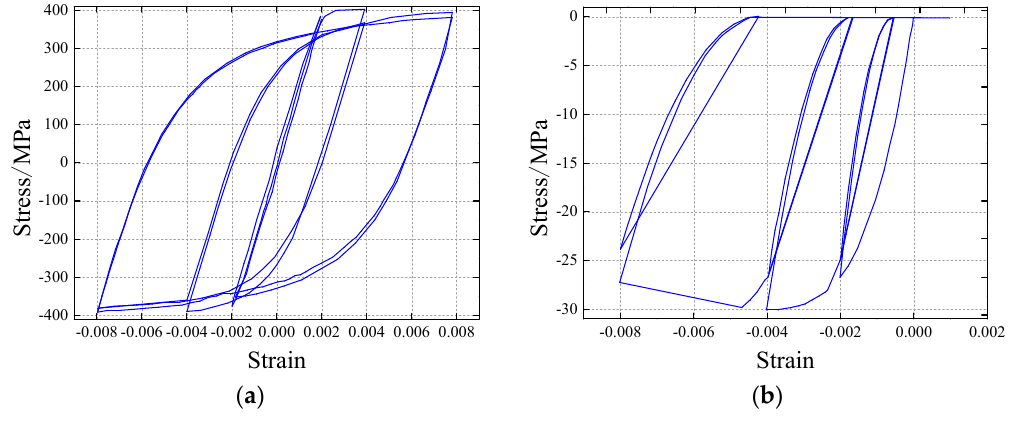
Figure 4. Stress–Strain Curve of Reinforced and Concrete. ( a ) Stress–strain relationship of reinforcement; ( b ) Stress–strain relationship of concrete.